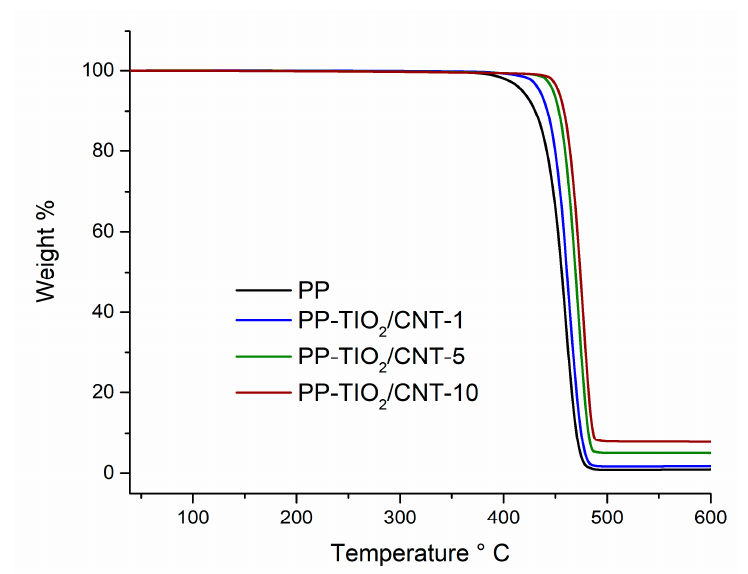
Figure 4. Thermogravimetric analysis of polypropylene (PP) and nanocomposites PP-TiO 2 / CNT (carbon nanotubes).